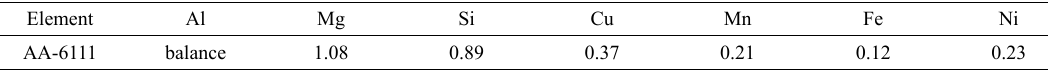
Table 2. Composition of the tested alloy (mass fraction, %).